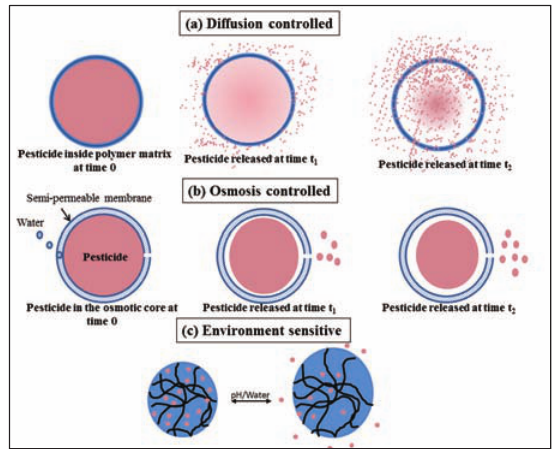
Fig. 3 Schematic of controlled release modalities from a polymer